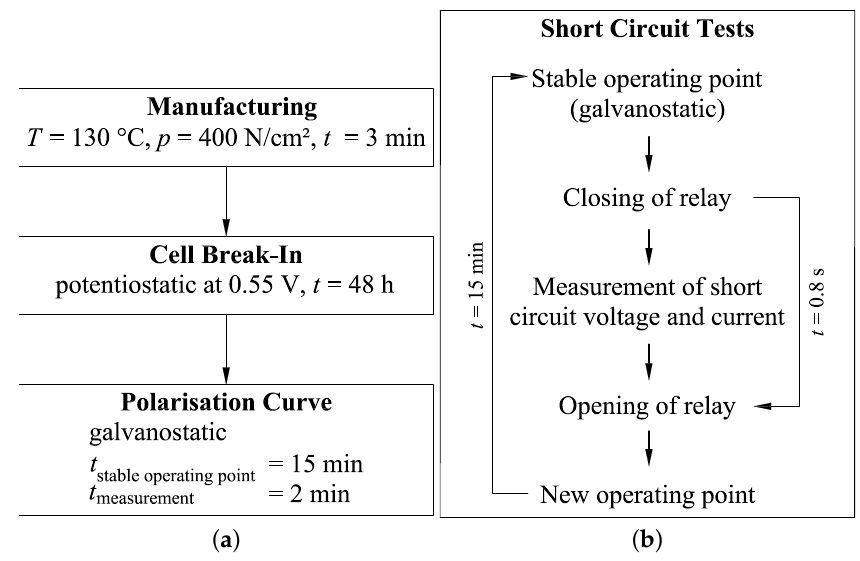
Figure 3. ( a ) Experimental sequence for the polarisation curve measurement and ( b ) for the